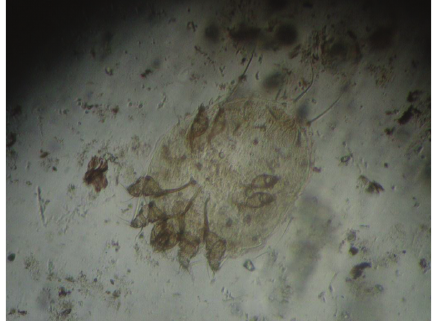
Figure 4: Scraping containing sarcoptic mites